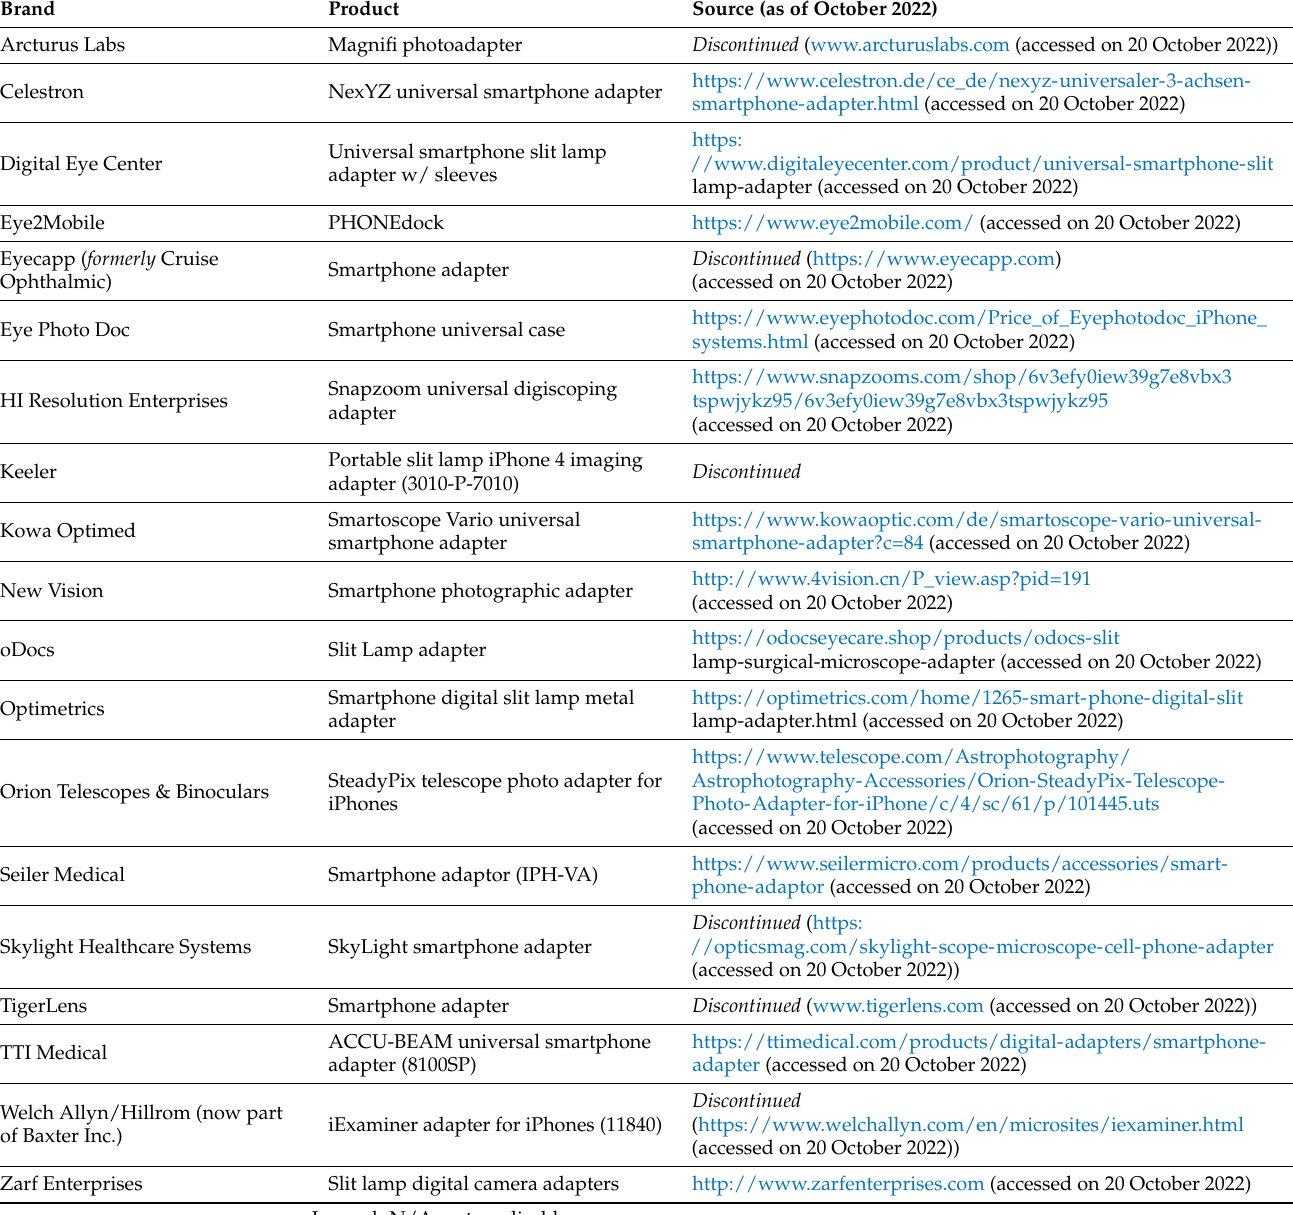
Table 6. Overview of selected smartphone slit lamp adapters in alphabetical order by brand name, identified by Google web searches for the search term smartphone slit lamp adapter (as of 9 October 2022) [no financial interest of